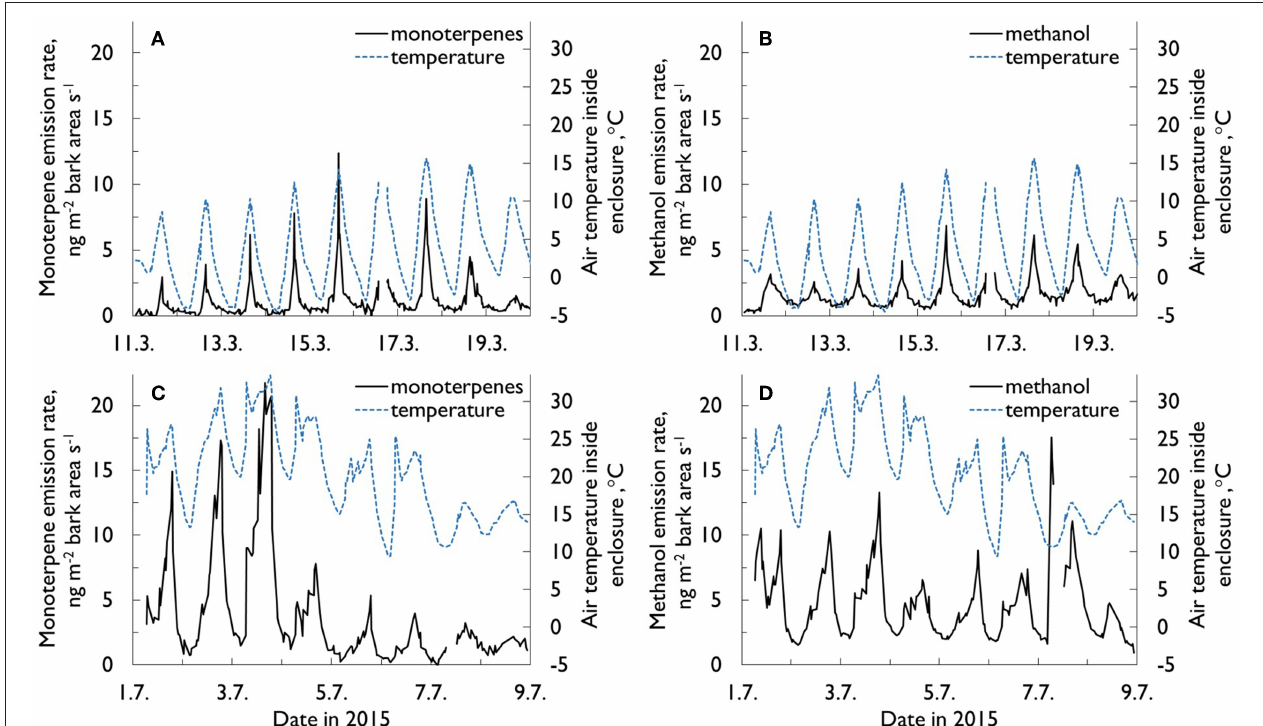
FIGURE 3 | The monoterpene (A,C) and methanol (B,D) emission rates (ng m − 2 s − 1 ) and air temperature ( ◦ C) inside the enclosure from within-canopy stem enclosure (# 5 at 12m) (A,C) during an exceptionally warm period in March 2015, and (B,D) a “normal” summer period in July 2015. On average, daily maximum and minimum temperatures at the site in March are 0.8 ◦ C and − 7.5 ◦ C, respectively. The corresponding July temperatures are 21.6 and 10.8 ◦ C ( Pirinen et al., 2012).